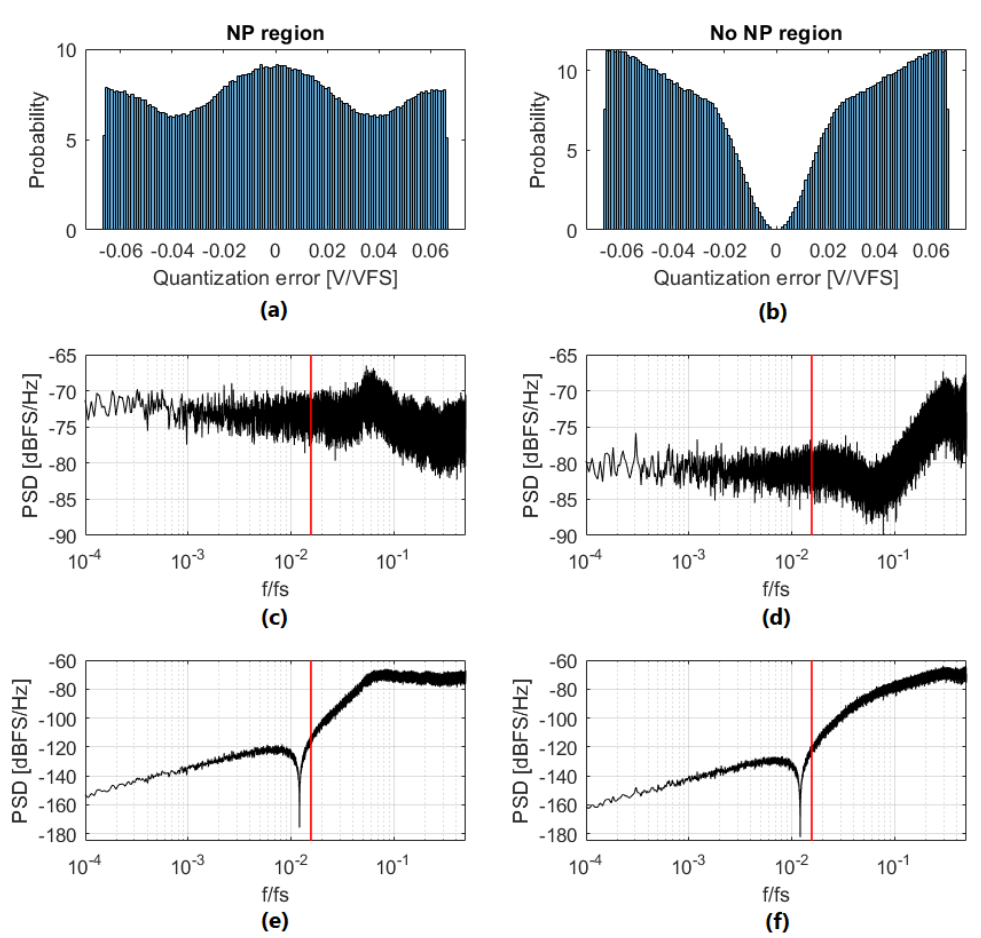
Figure 18. Quantization error comparison (in and outside of NP regions). Σ∆ M parameters are: third-order, 4-bits, OSR = 32, OBG = 1.5. Histogram of quantization error in NP regions ( a ) and outside of NP regions ( b ). PSD of quantization error in NP regions ( c ) and outside of NP regions ( d ); vertical red line marks the modulator bandwidth. PSD of quantization error at the Σ∆ M output in NP regions ( e ) and outside of NP regions ( f ); vertical red line marks the modulator